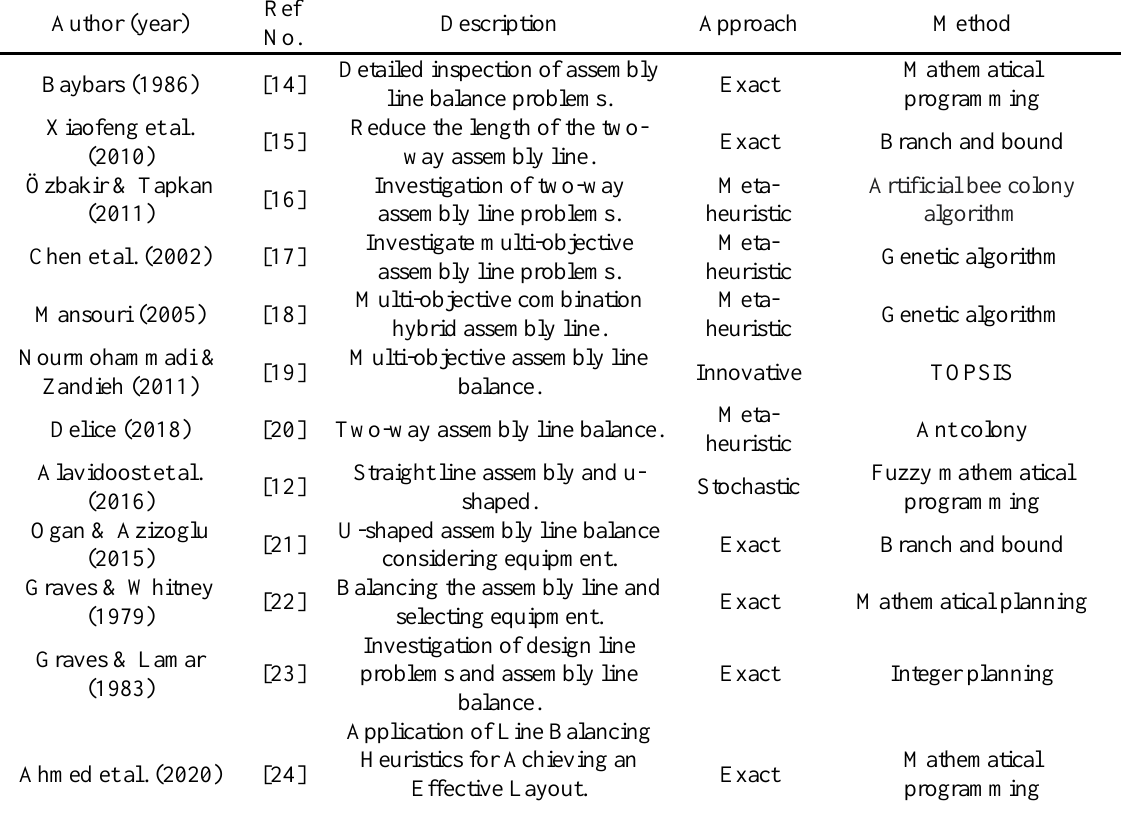
Table 1. Categorize articles and how to solve